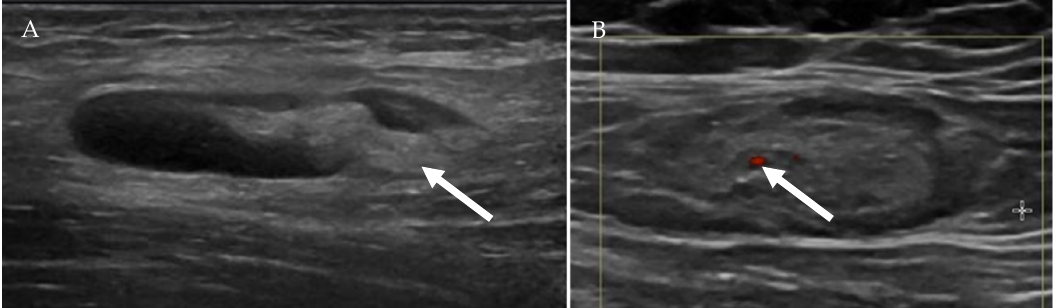
Figure 8. Ultrasound of a benign-appearing cervical lymph node ( A ) shows an oval hypoechoic lymph node with echogenic fatty hilum (arrow). Color doppler ultrasound of another benign-appearing lymph node ( B ) demonstrates a fatty hilum (normal) with mild hilar vascularity (arrow). Table 1. US and Doppler features of benign and malignant lymph nodes. There is no sole criterion to define malignant lymph nodes. Constellation of multiple features suggest malignancy. Addi- tionally, significant overlap between reactive and malignant lymphadenopathy remains.